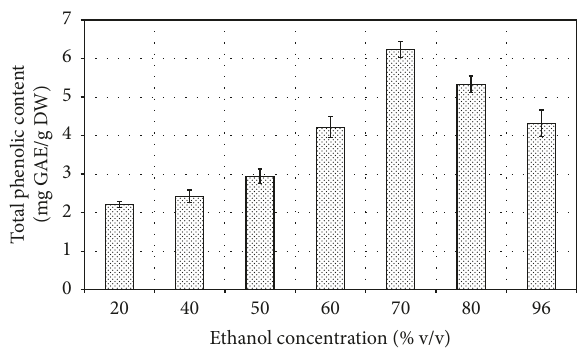
Figure 1: Effect of the concentration of the extractant on the extraction output of phenolic compounds from pear fruit samples.